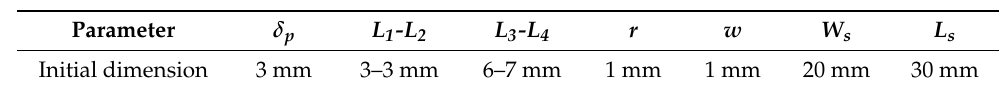
Table 1. Initial dimensions of sensitization